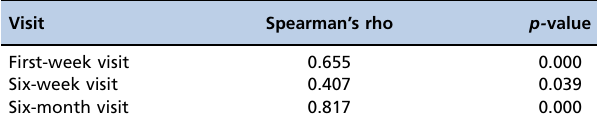
Table 3 - Correlation between patient cosmetic and operative satisfaction at different